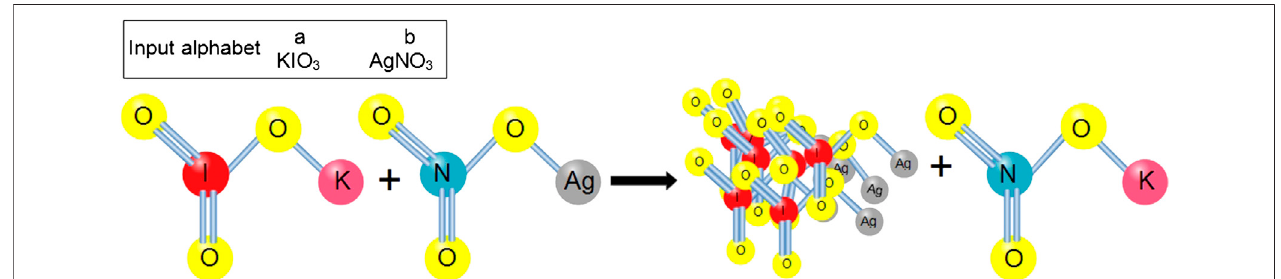
FIGURE 3 | Illustration of acid/base reaction of L 1